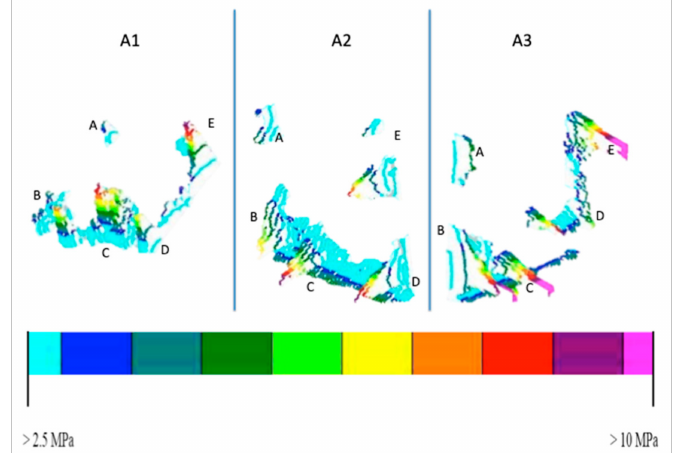
Figure 5. The 3D images of the 3 aligners, analysed as if they exerted pressure on the surface of parallelepiped. The colours shown in the figure indicate the various pressure variations. Green indicates lower pressures while yellow and red indicate higher